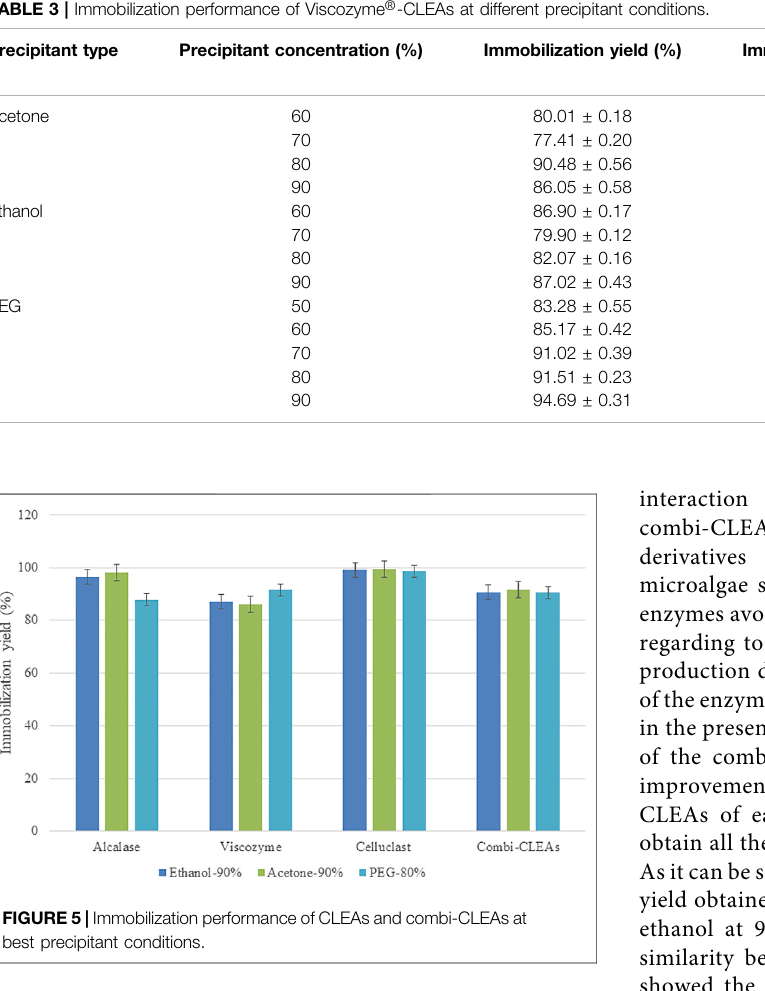
Frontiers in Bioengineering and Biotechnology |